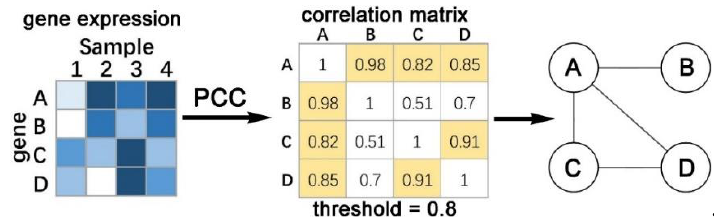
Figure 1. Constructing a relevance network using Pearson Correlation Coefficient